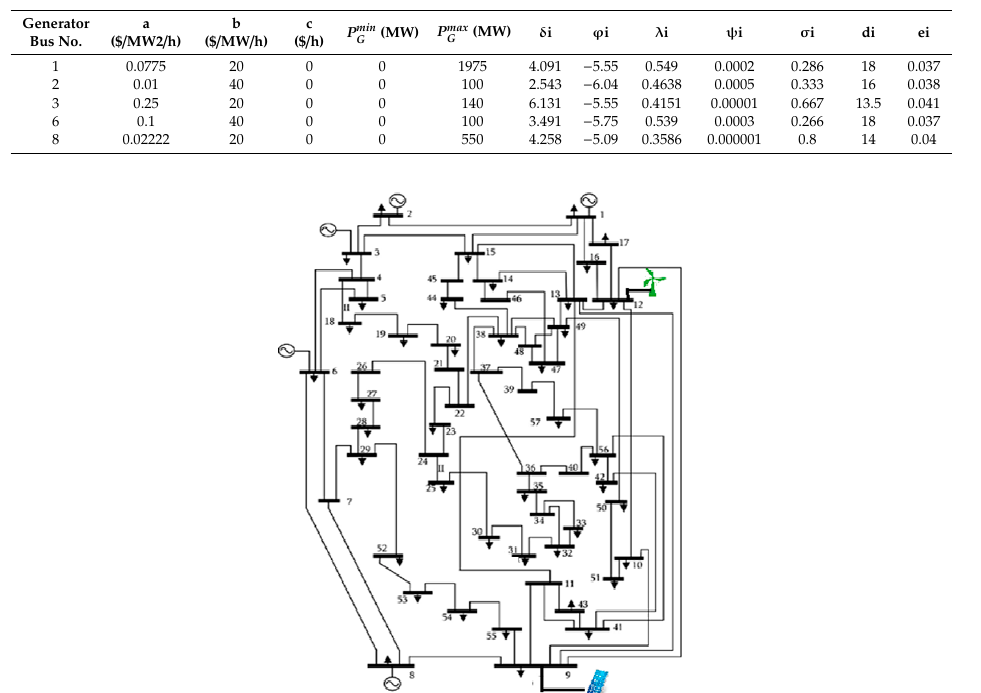
Table A1. Generator Characteristics of IEEE 57 Bus Systems.